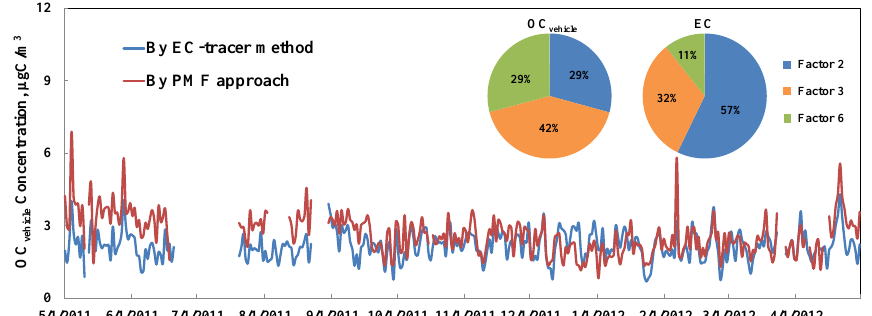
Figure 8. Time-series daily averaged OC vehicle (µgCm − 3 ) estimated by means of the EC-tracer method (blue curve) and the PMF approach (red curve) at MK AQMS during May 2011–April 2012. The relative contributions of different vehicular emission-related factors to the OC vehicle and EC, estimated by means of PMF, are shown in the pie charts.